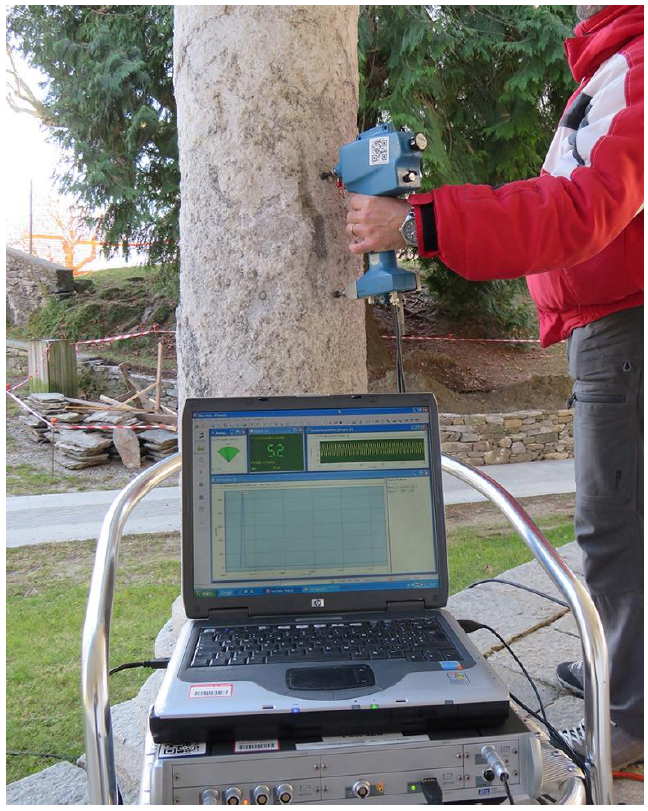
Figure 5. Setup of the impact test.